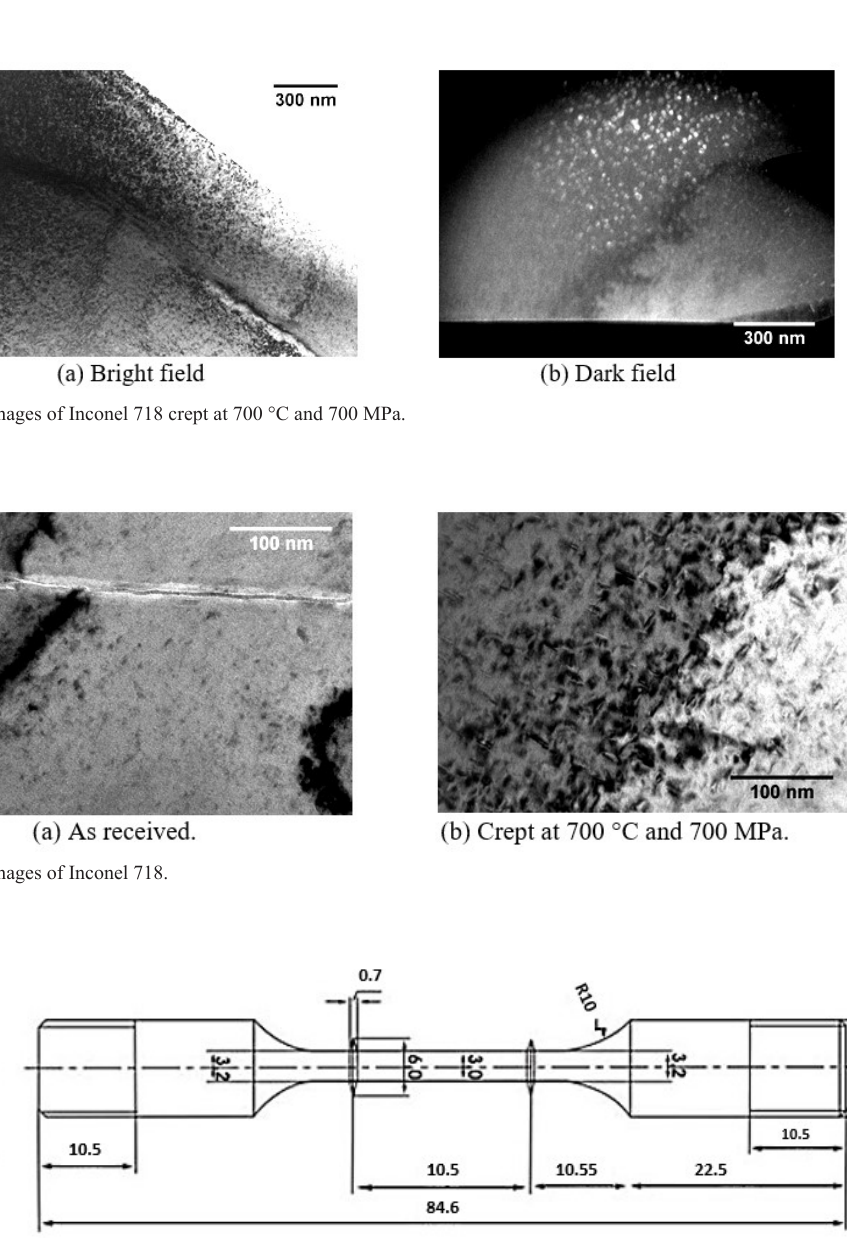
Figure 8. Schematic view of the specimen for creep test 17